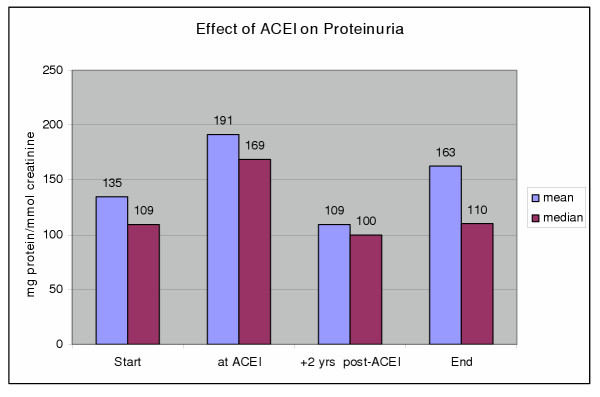
Effect of ACEI on Proteinuria. Time points are 1) start of study, 2) at begin of ACEI therapy, 3) 2 years after begin ACEI; 4) at end of study. Proteinuria* at ACEI vs +2 years post-ACEI; p < 0.0001.